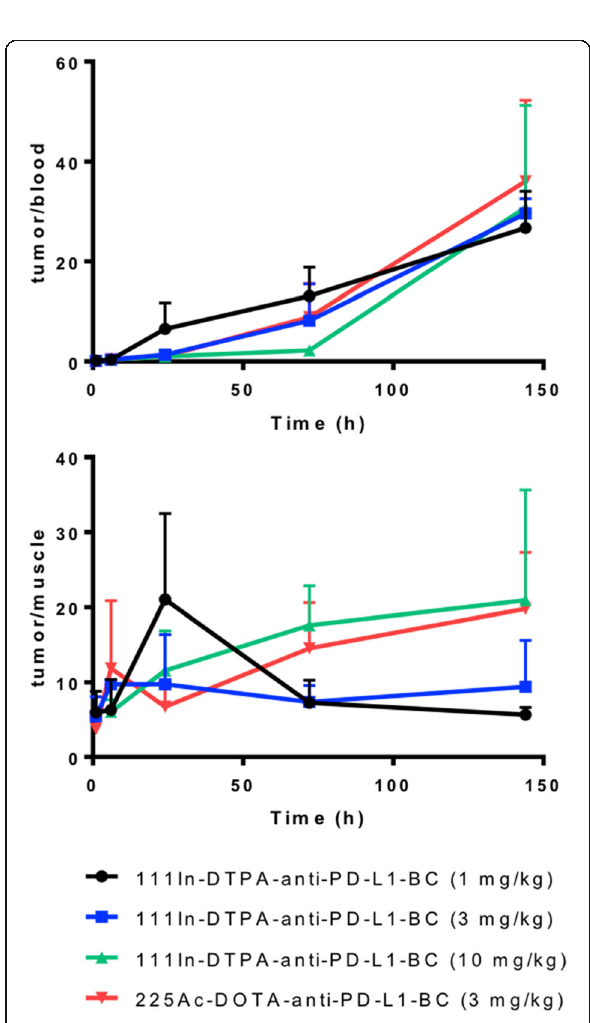
Fig. 3 Tumor to blood and tumor to muscle activity concentration ratios for individual